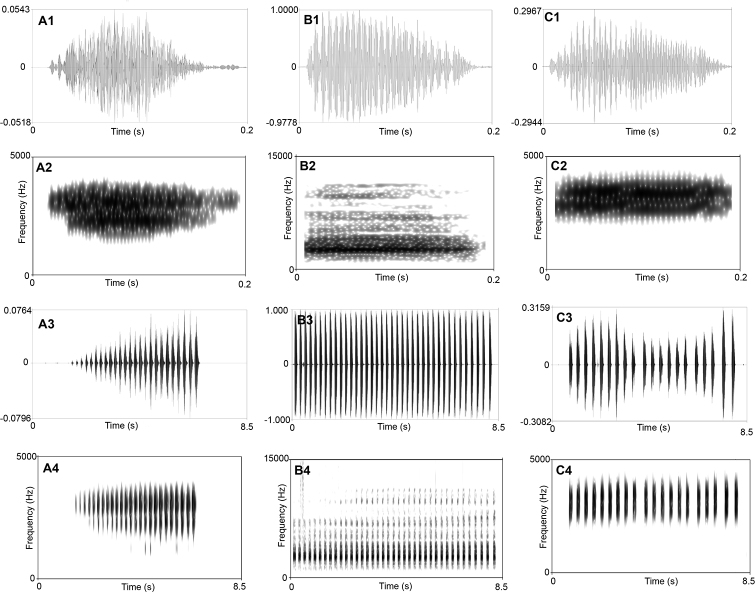
Visualization of advertisement calls of Megophrys
qianbeiensis sp. nov., M.
sangzhiensis, and M.
spinataA1 waveform showing one note of Megophrys
qianbeiensis sp. nov. A2 sonogram showing one note of Megophrys
qianbeiensis sp. nov. A3 waveform showing 25 notes of one call of Megophrys
qianbeiensis sp. nov. A4 sonogram showing 25 notes of one call of Megophrys
qianbeiensis sp. nov. B1 waveform showing one note of M.
sangzhiensisB2 sonogram showing one note of M.
sangzhiensisB3 waveform showing 38 notes of one call of M.
sangzhiensis. B4 sonogram showing 38 notes of one call of M.
sangzhiensisC1 waveform showing one note of M.
spinataC2 sonogram showing one note of M.
spinataC3 waveform showing 20 notes of one call of M.
spinataC4 sonogram showing 20 notes of one call of M.
spinata.